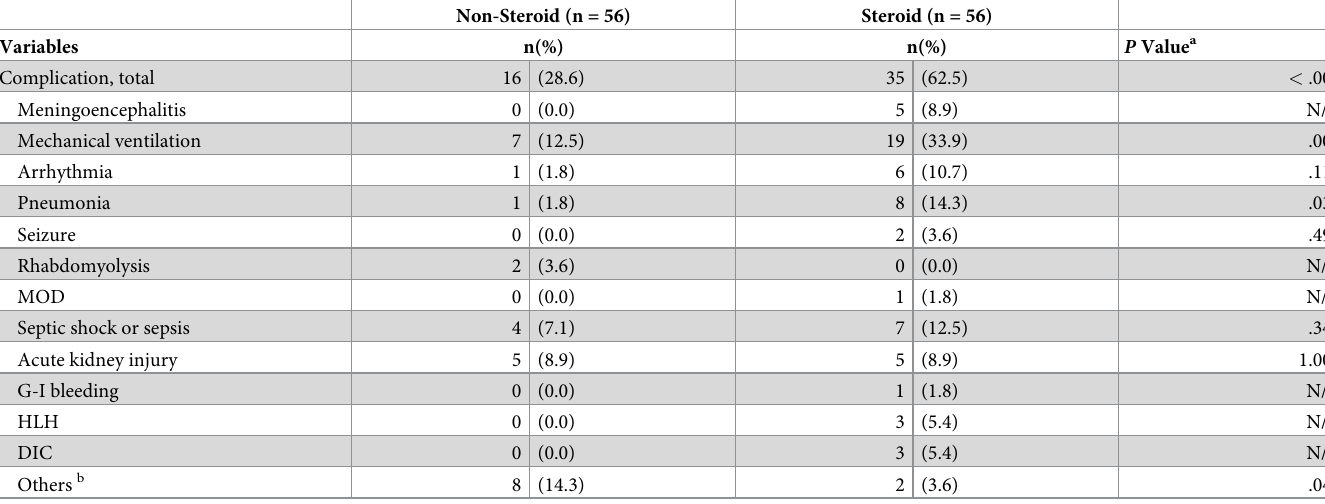
Table 7. Comparison of Complication Frequencies Between the Steroid and Non-Steroid Groups in Patients with SFTS after Propensity Score